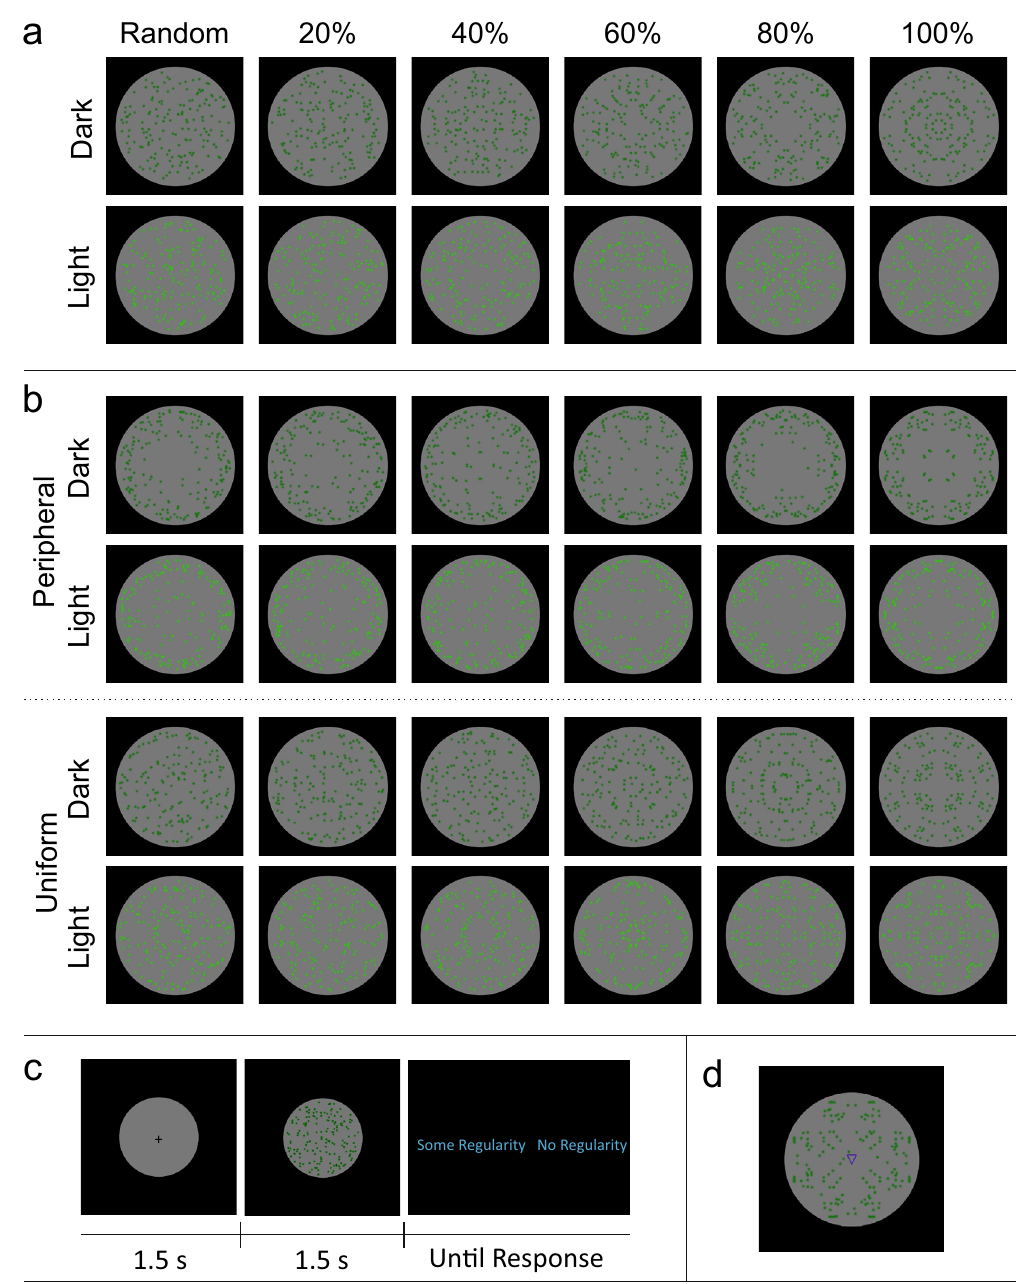
Figure 13. Stimuli and procedure from Makin et al. 24 . ( a ) Patterns used in the regularity, color, sound/color and direction/color tasks. Columns illustrate increasing PSYMM, rows indicate dark/light green stimuli. ( b ) Stimuli used in distribution task. ( c ) Experimental paradigm for regularity task. All other tasks differed only in the binary judgement required (light green/dark green; congruent/incongruent; uniform/outside). ( d ) Stimulus with directional triangle from direction/color